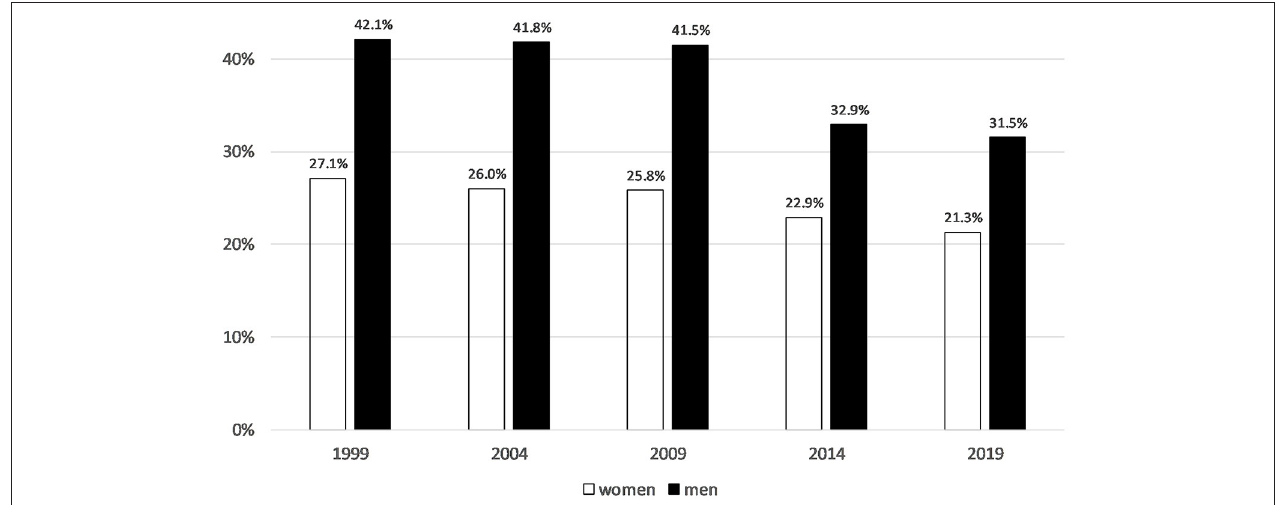
FIGURE 6 | Proportion of persons in volunteer leadership positions among persons with the most time-consuming voluntary activity in the sports sector (1999 N = 1,192, 2004 N = 1,166, 2009 N = 1,336, 2014 N = 2,832, 2019 N = 2,454). German Survey on Volunteering (FWS).